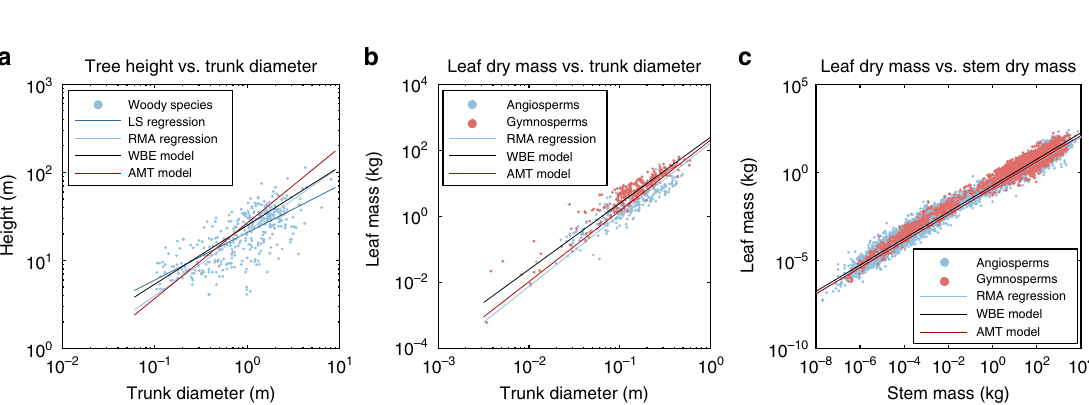
Fig. 6 Comparison of the AMT model with empirical data. a Scaling of plant height as a function of stem diameter. The allometric data of ref. 48 for woody 48 , reduced major axis (RMA) regression H ¼ 21 : 4 d 0 : 73 50 , WBE model H ¼ 25 d 0 : 67 species are compared to least square (LS) regression H ¼ 20 : 7 d 0 : 538 trunk trunk trunk and present AMT model H ¼ 26 : 7 d 0 : 857 (Methods section and Supplementary Discussion). b Allometric data on leaf dry mass vs. trunk diameter 5 are trunk 5 , WBE model M ¼ 247 d 2 compared to RMA regression M L ¼ 166 d 2 : 17 and AMT model M L ¼ 202 d 2 : 14 . c Allometric relations between leaf dry mass L trunk trunk trunk and stem dry mass from more than 11,000 records 6 are compared to RMA regression M L ¼ 0 : 113 M S 0 : 74 6 , WBE model M L ¼ 0 : 176 M S 0 : 75 and AMT model M L ¼ 0 : 124 M S 0 :